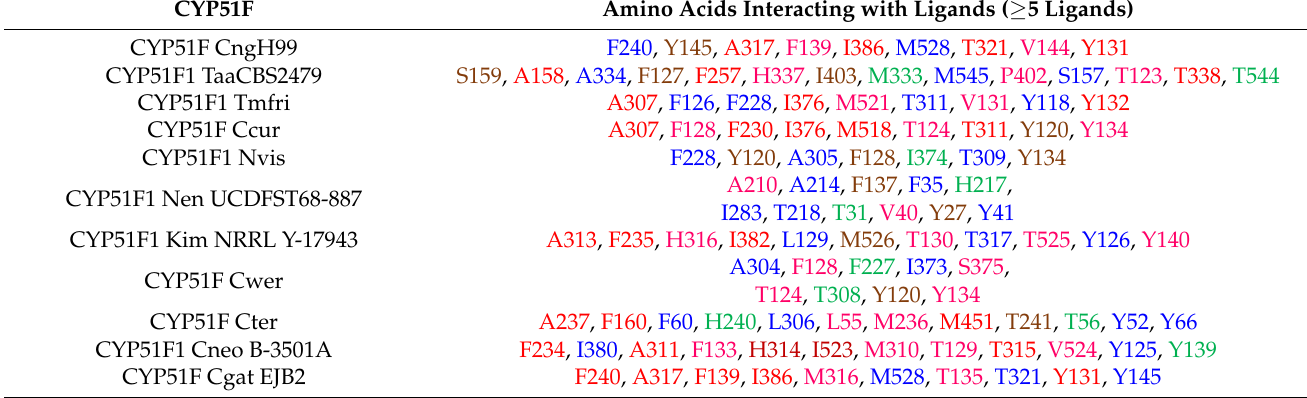
Table 2. Analysis of Tremellomycetes CYP51s amino acids interacting with different ligands. Amino acids interacting with ≥ 5 ligands are presented in the table. Amino acids are colored based on their interactions with nine ligands (red), eight ligands (blue), seven ligands (brown), six ligands (green), and five ligands (pink). A complete list of amino acids interacting with different ligands is listed in Table